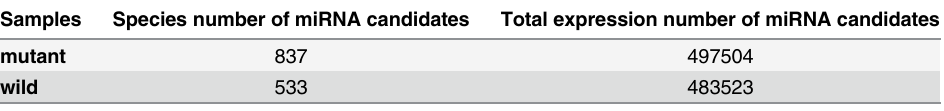
Table 5. Statistics of predicted novel miRNA precursors.